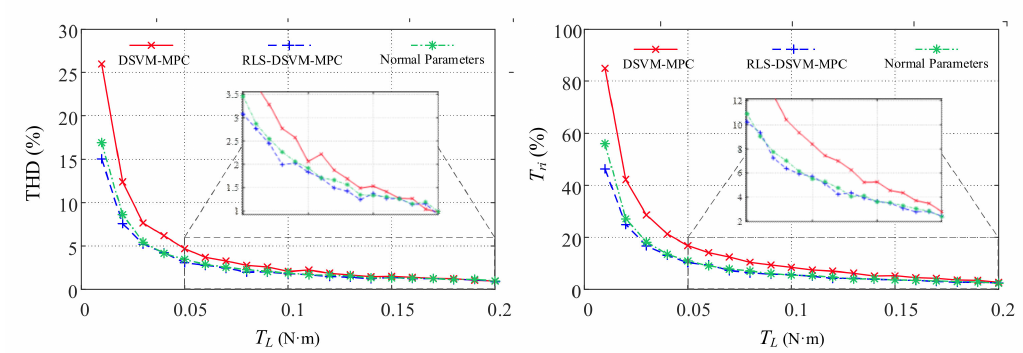
Figure 17. Performance of DSVM-MPC and RLS-DSVM-MPC at different loads.